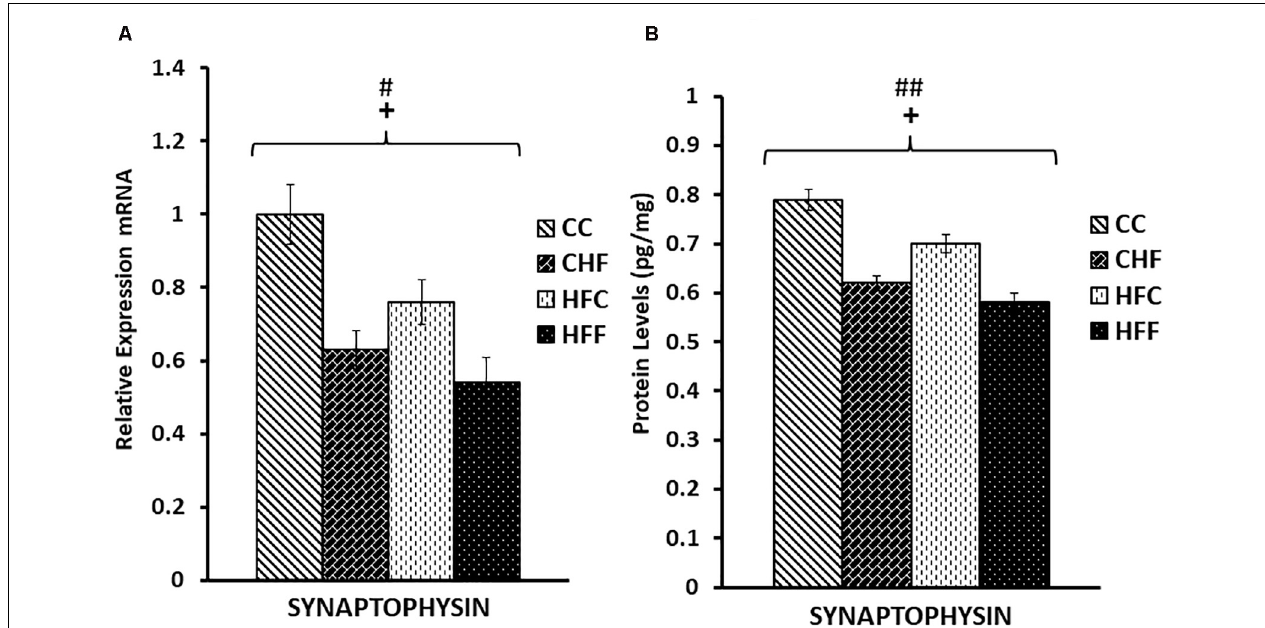
FIGURE 6 | Relative levels of Synaptophysin mRNA and protein expression in the hippocampus. (A) Using real-time PCR, hippocampal synaptophysin mRNA expression was significantly reduced in response to both maternal ( F ( 3 , 39 ) = 4.14, P = 0.038) and post-weaning high-fat diets (post-weaning diet effect; F ( 3 , 39 ) = 7.47, P = 0.014). Values are expressed in relative units where CC group is set to 1. (B) Significant reductions in synaptophysin protein levels (pg/mg) were also detected in response to both the maternal ( F ( 3 , 39 ) = 6.65, P = 0.032) and post-weaning HF diets ( F ( 3 , 39 ) = 8.64, P = 0.004) using ELISA. No significant interactions were detected using two-way ANOVA. Values are means + SEM ( n = 16 for each group). + P < 0.05 (significant maternal diet effect); # P < 0.05, ## P < 0.01 (significant post-weaning diet effect).